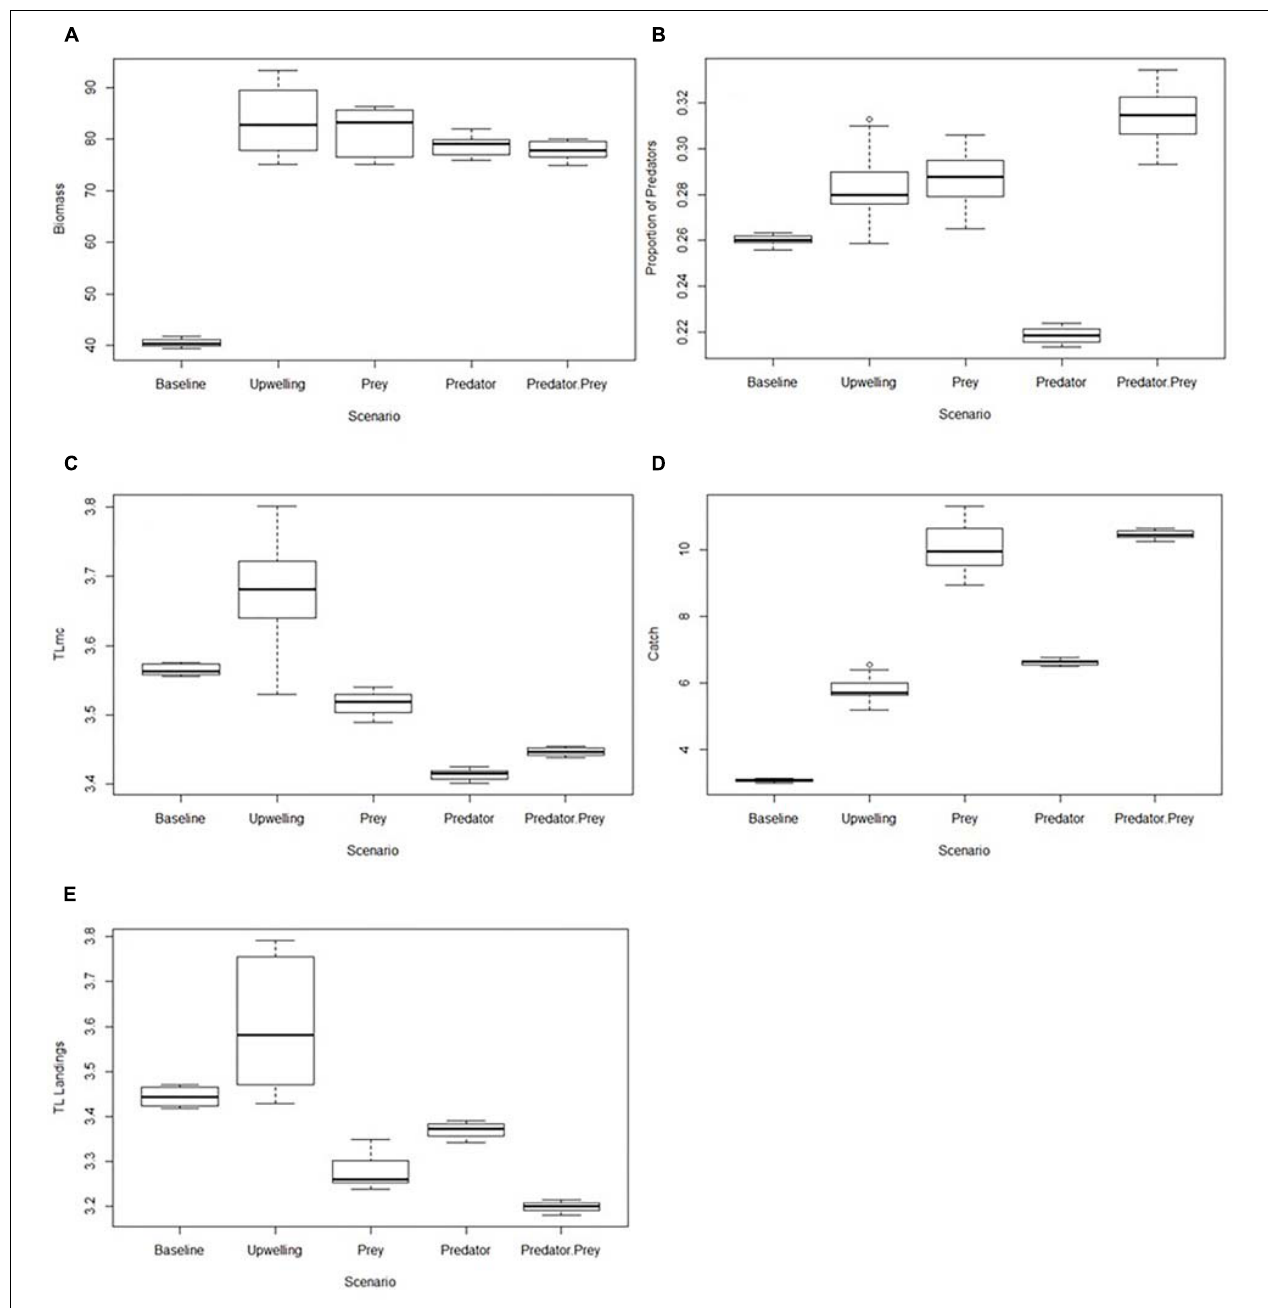
FIGURE 1 | (A–E) Boxplots of ANOVA results for each indicator comparing the end-state (final 10 years of data) for each scenario. (A) Biomass, (B) Proportion of predators, (C) Trophic level of the modeled community (TLmc), (D) Catch, and (E) Trophic level of landings.